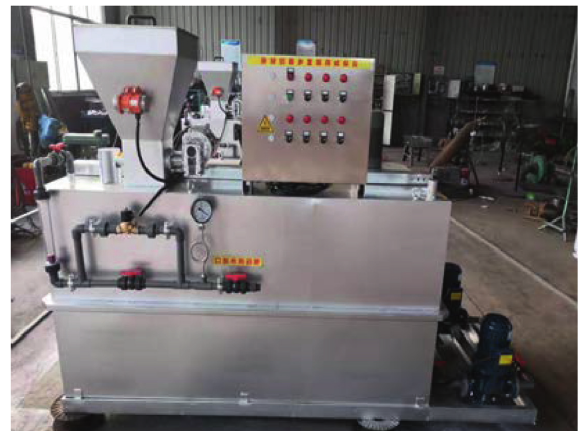
Figure 6: Real figure of flocculant automatic dosing machine.